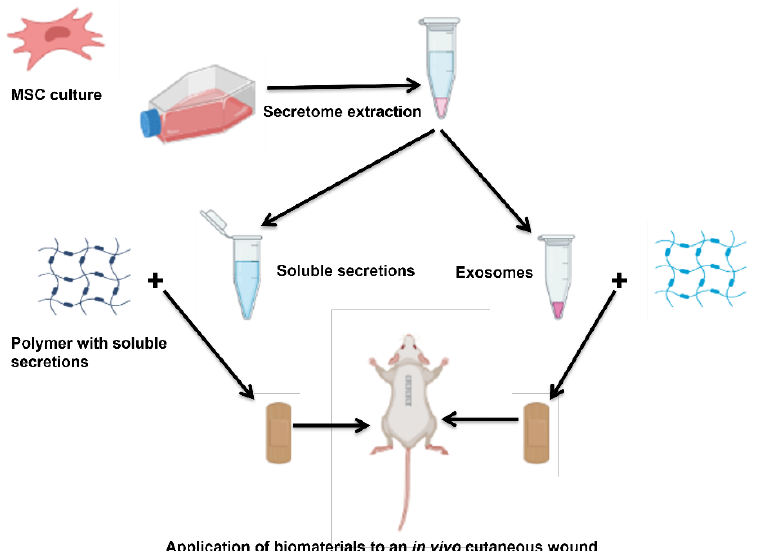
Figure 3. Schematic representation of MSC secretome extraction and exosome separation and combination with polymers for in vivo wound application.